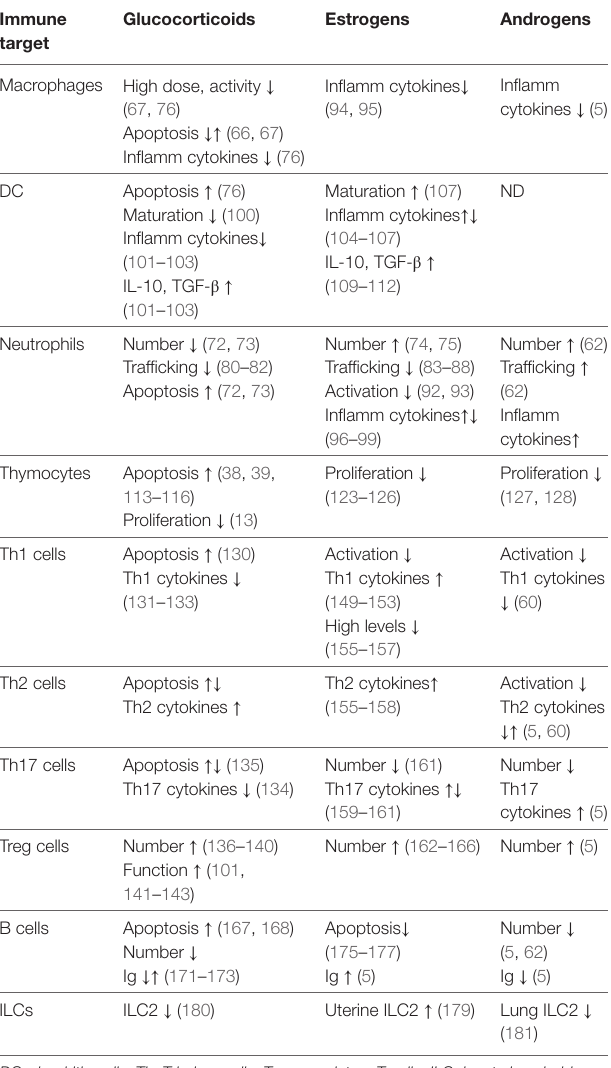
TAble 1 | Effect of steroid hormones on innate and adaptive